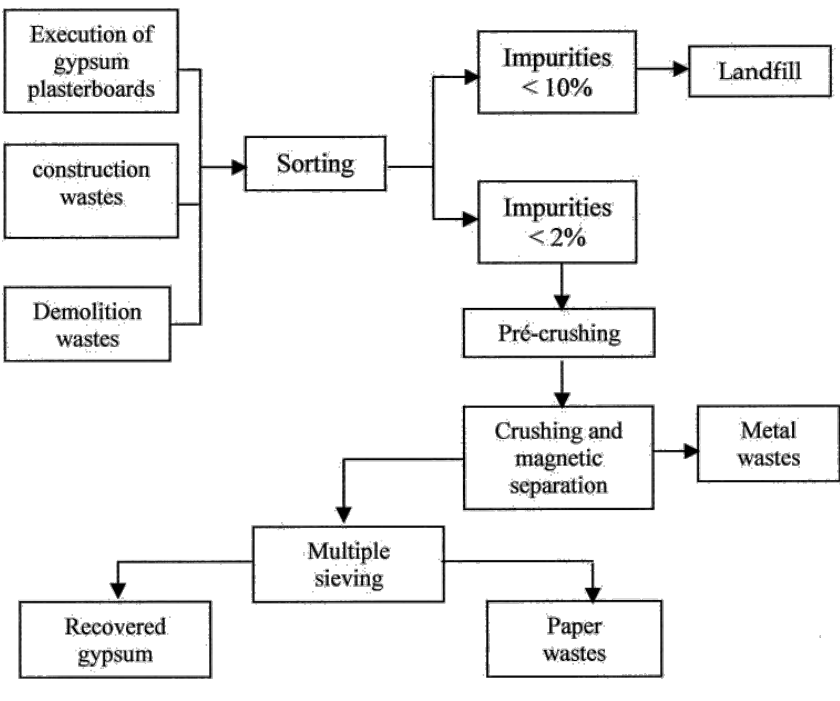
Figure 9. Recycling of gypsum plasterboard [115,146].